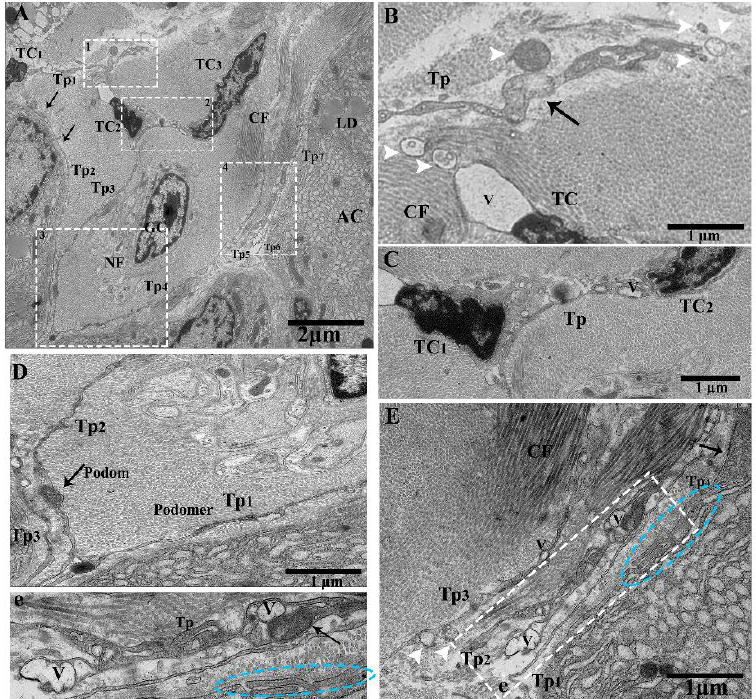
Figure 1. Ultrastructure of telocytes between lobules in connective tissue, shading vesicles / extracellular vesicles releasing form podoms, close connection with Tps–Tps and collagen fiber. Transmission electron microscope (TEM) images of a turtle pancreas showing close proximity with nerve cells, glial cells, the acinar, and collagen fibers. ( A ) Contains three TCs (TC 1 , TC 2 , TC 3 ). The nucleus contains heterochromatin and a peripheral attachment with an irregular shape. The cell body of TC 2 and TC 3 bearing junctions at TP 3 . Long beaded-like telopodes, Tps (Tp 2 , Tp 3 , Tp 4 , Tp 5 , and Tp 6 ), harboring alternating podoms and podomers (arrows). The square-marked areas 1, 2, 3, and 4 in ( A ) are enlarged in ( B , C , D , E ), respectively. ( B ) Extracellular vesicles (EVs; white arrowheads) released from the podoms in the connective tissue in the vicinity of collagen fibers (arrow). ( C ) TC 1 and TC 2 have a common connection—their Tps contain small bubble-like vesicles. ( D ) Long cylinder Tps (Tp 1 , Tp 2 , Tp 3 ), which have common nano-connections with thick and thin segments (podoms and podomers) and contain mitochondria and vesicles in their podoms. ( E ) Enlarged in ( e ). The Tps contain homo-cellular and hetero-cellular junctions between Tps–Tps and collagen fibers, and contain mitochondria, caveolae, and vesicles in their podoms (arrow). Blue circled area in ( E , e ) shows the short overlap of Tps, and the white arrowheads indicate EVs. TCs, telocytes; Tps, telopodes; GC, glial cells; NF, nerve fibers; rER, rough endoplasmic reticulum; podoms and podomers, arrows; LD, lipid droplet; AC, acinus; CF, collagen fibers; V, vesicle. Scale bar = 2 µ m in ( A ); scale bar = 1 µ m in ( B – E